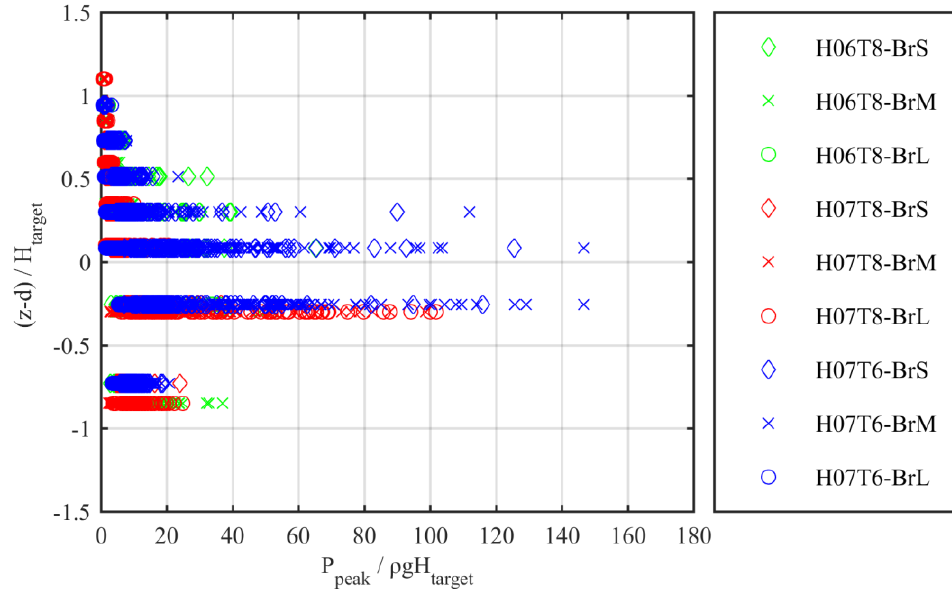
Figure 9. Distribution of pressure peaks over relative location of pressure transducers along the seawall for impulsive conditions.